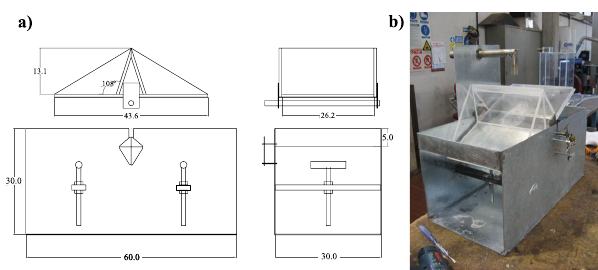
Figure 4. Tipping bucket flow gauge. (a) Dimensions of the flow gauge. All dimensions in centimeters. (b) Completed flow gauge constructed from sheet metal and plexiglas.